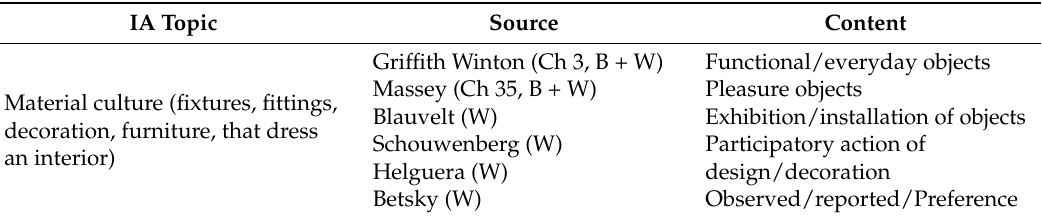
Table 3. Selected preliminary content analysis of selected key texts—material